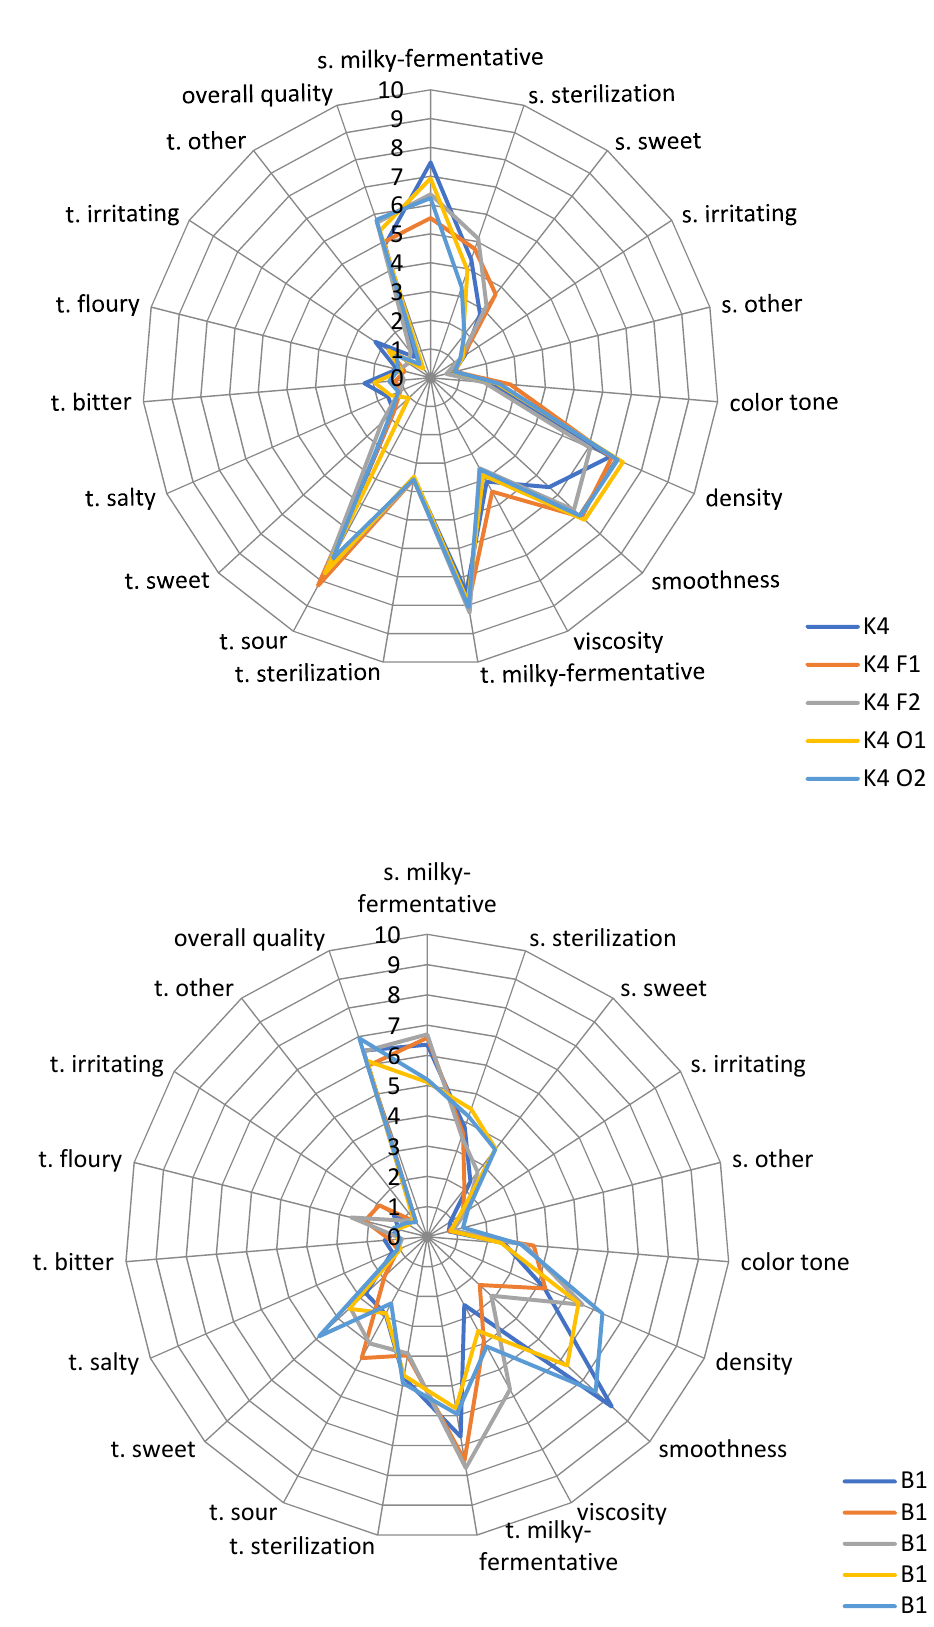
Figure 3. Sensory profiles of milk samples fermented with L. johnsonii K4 ( A ) and L. brevis B1 ( B ). Samples codes according to Materials and methods section; ( n = 3).